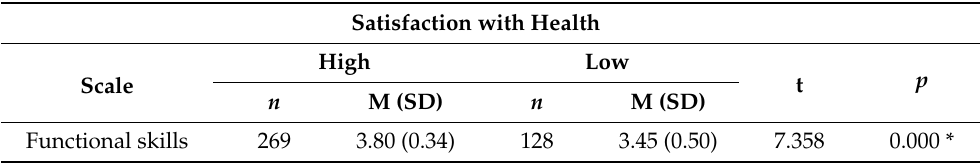
Table 1. Means, standard deviations and t -tests of the scores on the functional abilities scale according to the level of satisfaction with health. Satisfaction with Health High Scale Functional skills